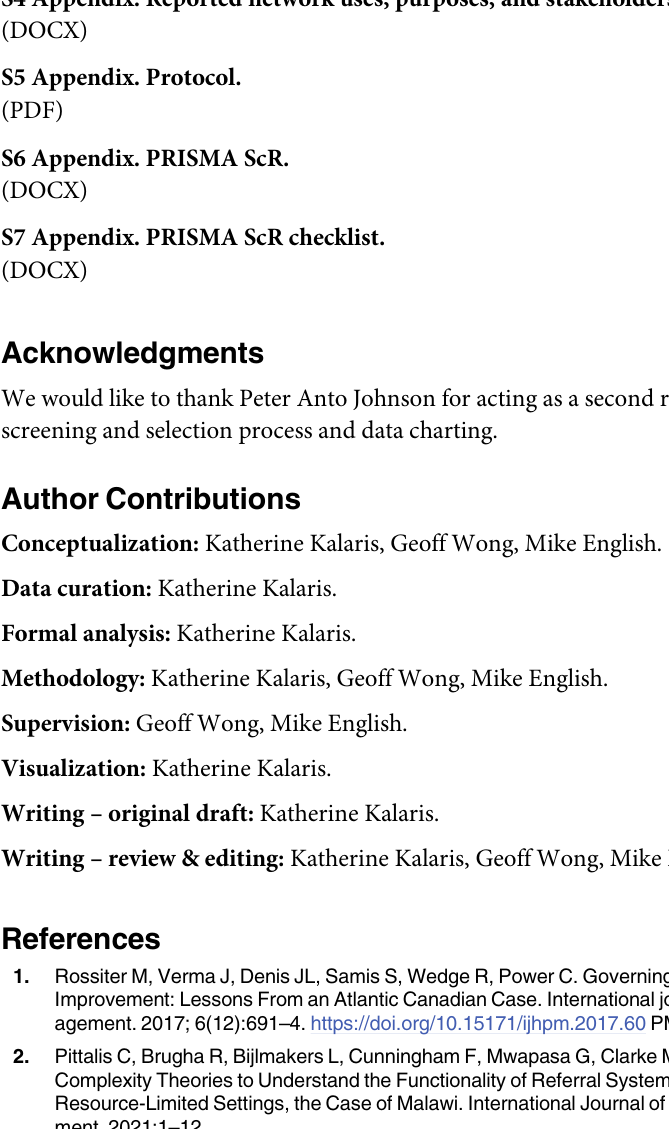
S3 Table. Existing network frameworks and typologies identified. S4 Table. Most frequent practical characteristics by network component with examples from the selected